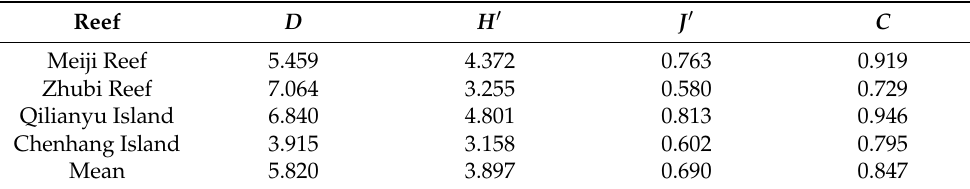
Table 5. Diversity indices of fish in Meiji Reef, Zhubi Reef, Qilianyu Island and Chenhang Island. Reef